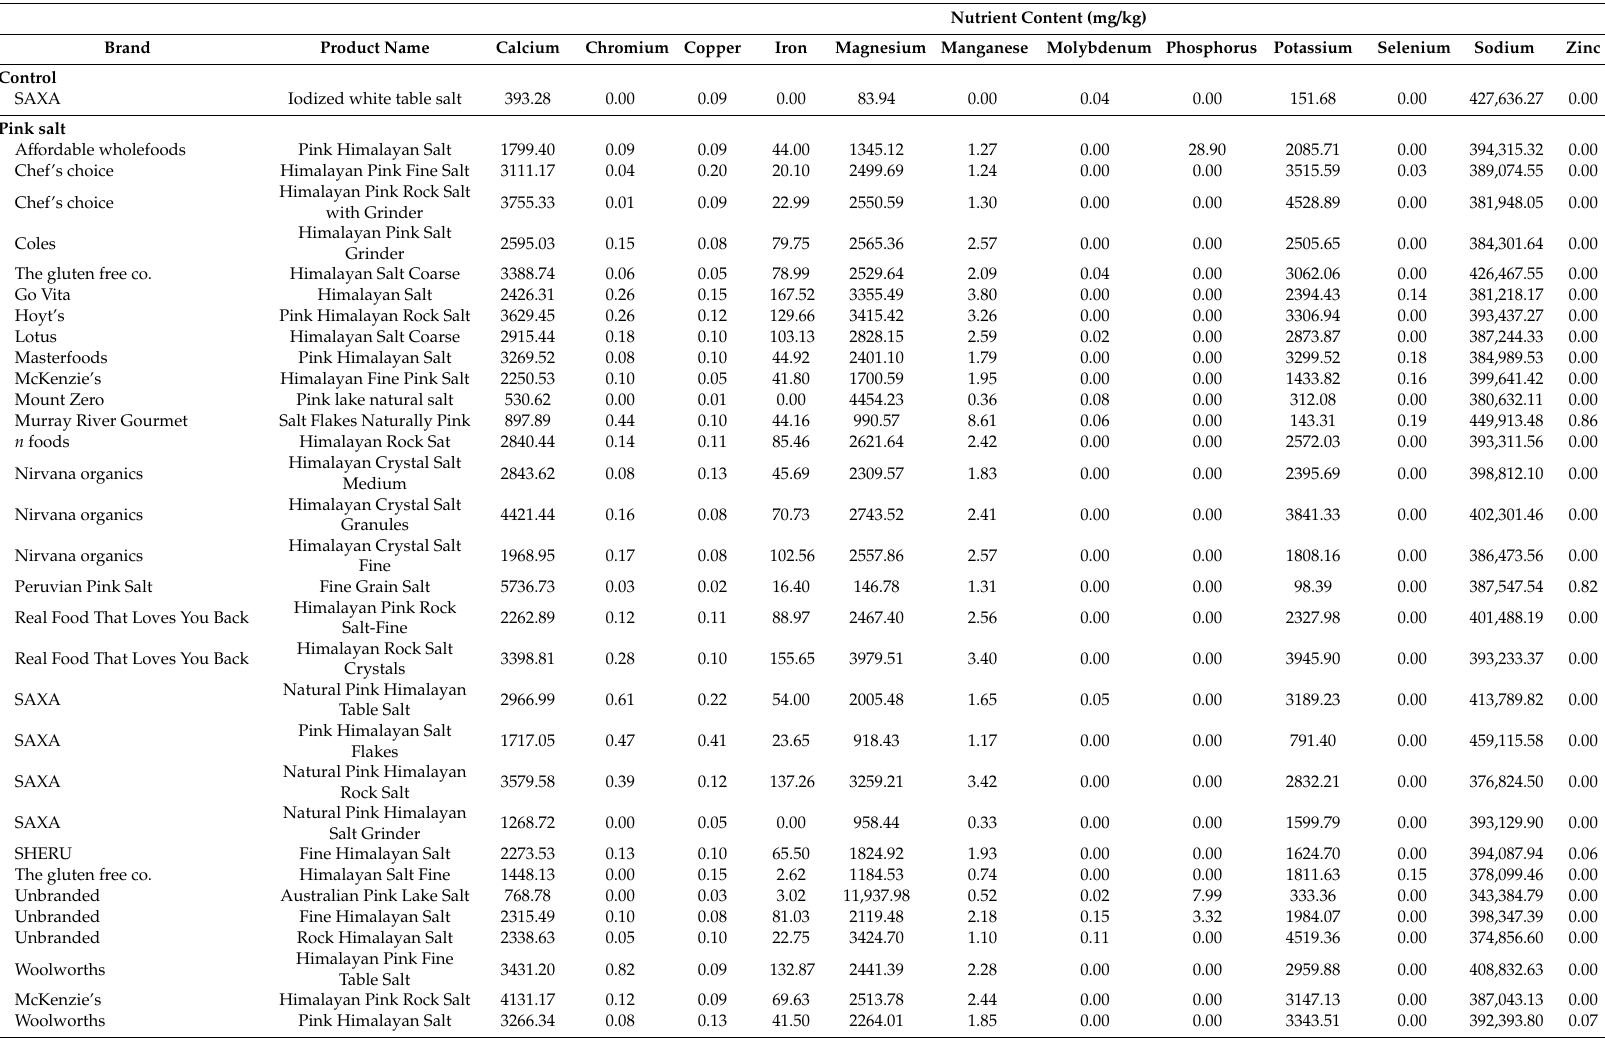
Table 2. Composition of nutrients in pink salt ( n = 31) and iodized white table salt ( n = 1) samples which were purchased from retail stores in Australia in June